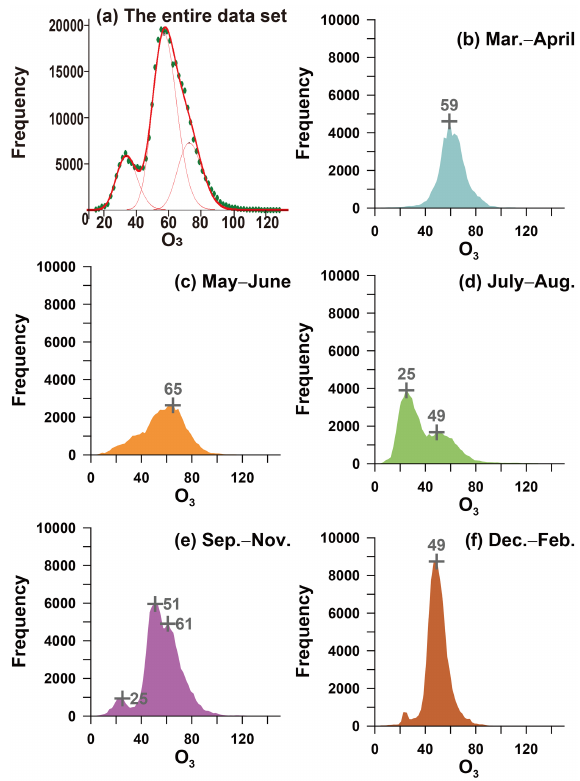
Figure 6. Frequency distributions of 10min averaged O 3 concen- trations at IORS for (a) all data, (b) spring, (c) dry summer, (d) wet summer, (e) fall, and (f) winter with mode concentrations given.